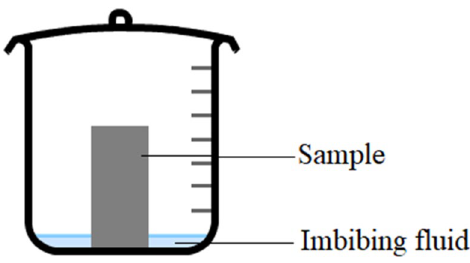
Figure 1. Schematic of water/oil imbibition setup.